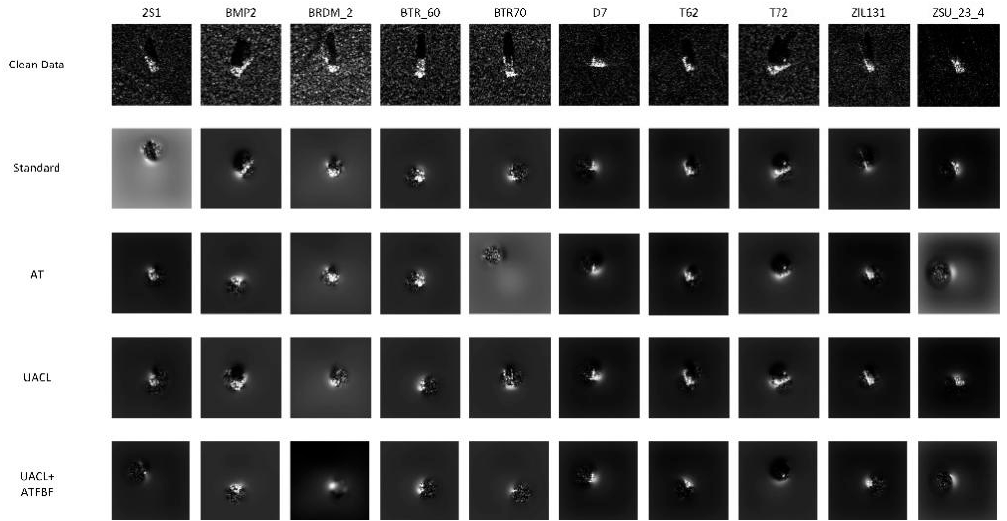
Figure 13. Extremal perturbations images of MSTAR model in the classification of clean data.